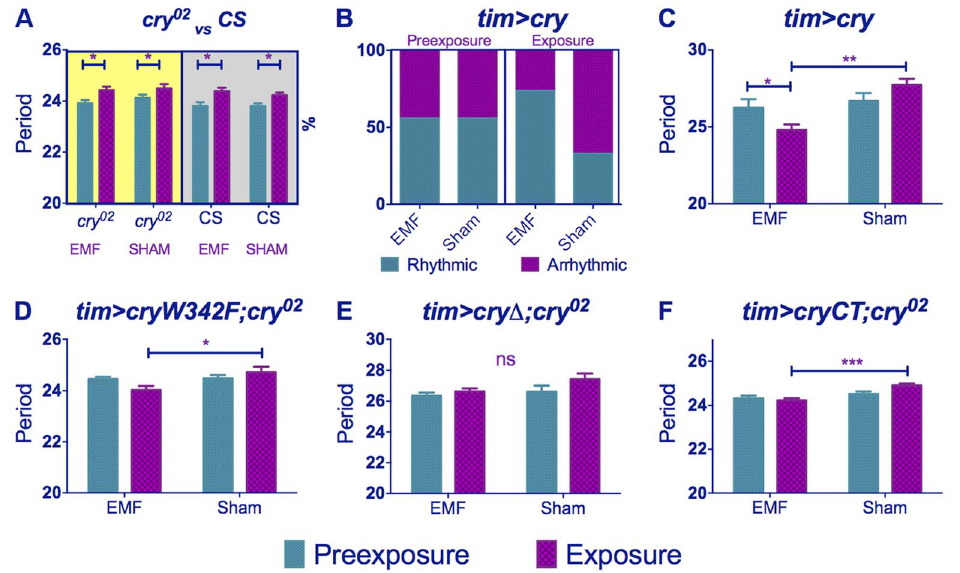
Figure 3. cry variants alter normal circadian responses to EMFs. Circadian periods (h) in dim blue LL are shown for EMF and sham-exposed groups. Mean periods 6 sem. (A) cry 02 flies exposed to EMF show only ageing effects on period (yellow shaded box). Wild-type flies kept in DD (grey shaded box) show similar ageing effects (B) tim . cry % rhythmic/arrhythmic flies during pre-exposure and exposure to EMF or sham. Exposure to EMF dramatically increases the proportion of rhythmic flies ( x 2 (3) =12.78, p , 0.01). (C) tim . cry period for EMF exposed and sham flies before and during exposure (D) tim . cryW342F;cry 02 (E) tim . cry D ;cry 02 . (F) tim . GFPcryCT;cry 02 . (See Table S1, post-hoc *p , 0.05, **p , 0.01, ***p , 0.001).